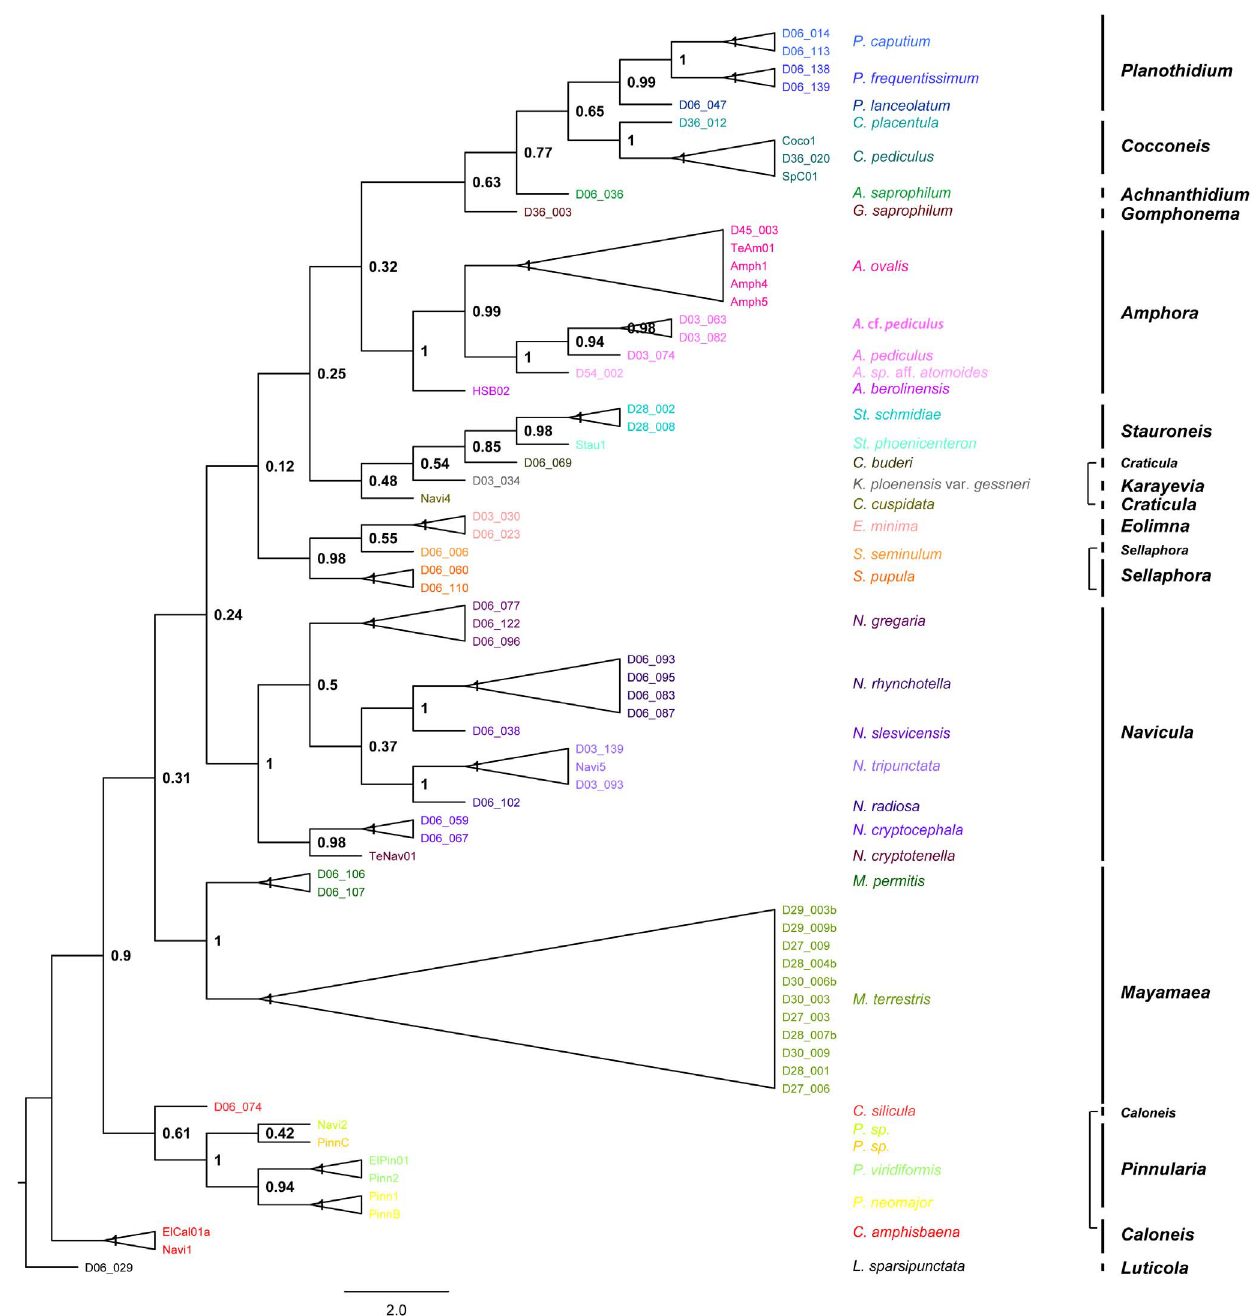
Figure 6. Neighbour Joining Tree (10 000 bootstrap replicates) derived from concatenated dataset (18S V4, rbc L) including all sequences from this study. All bootstrap support values given above branches.